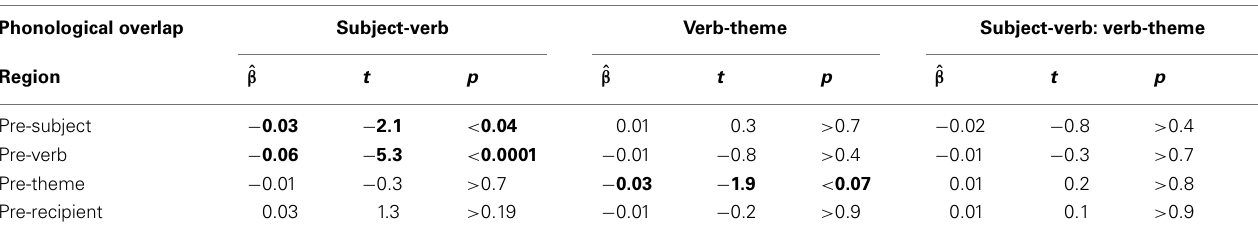
Table 3 | Speech rate results by sentence region.